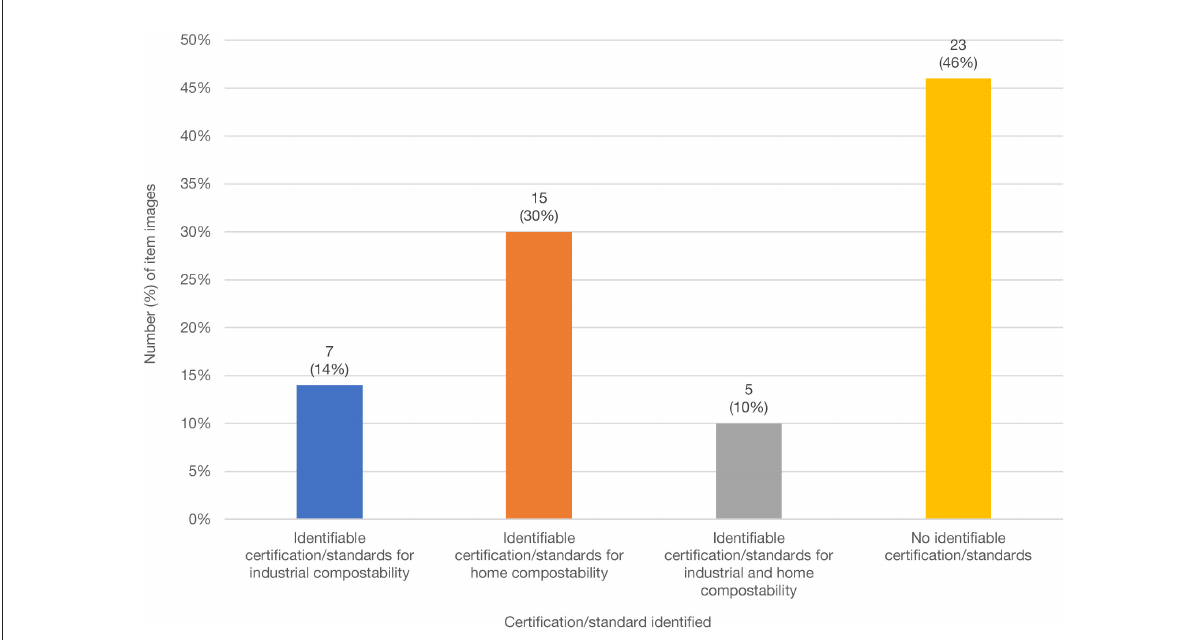
Figure 4 for the full distribution). When asked what they